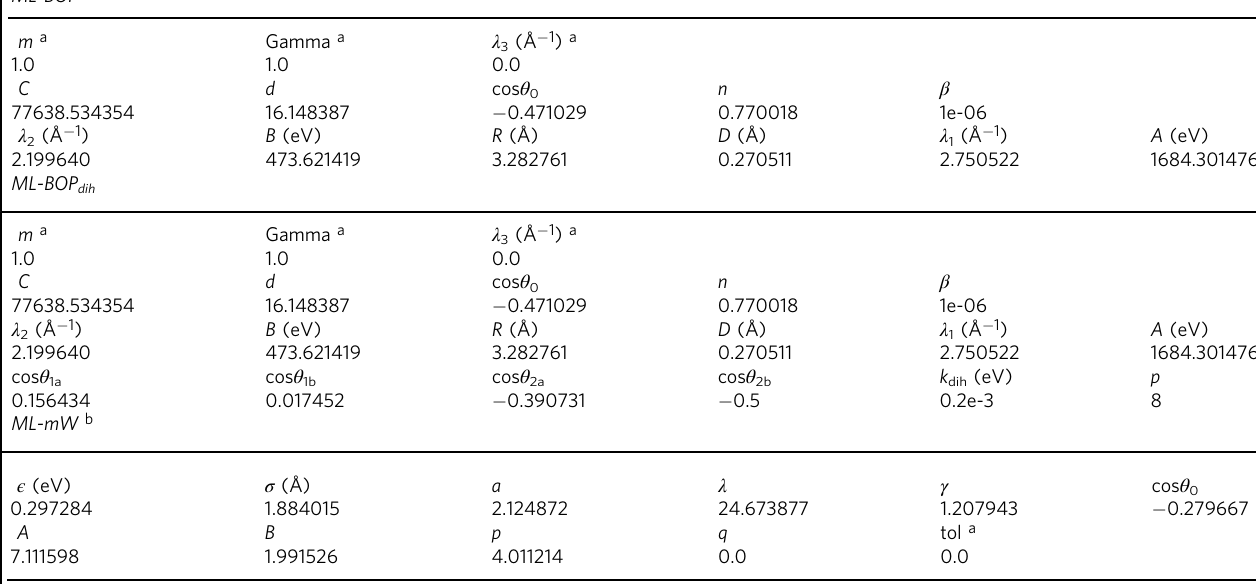
Table 3 Force fi eld parameters of ML models optimized using our developed work fl ow